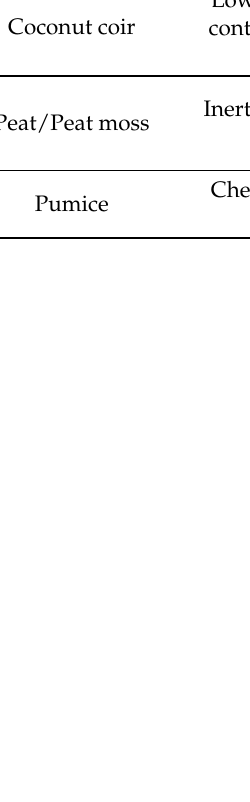
Table 2. Most suitable plants to grow by hydroponics